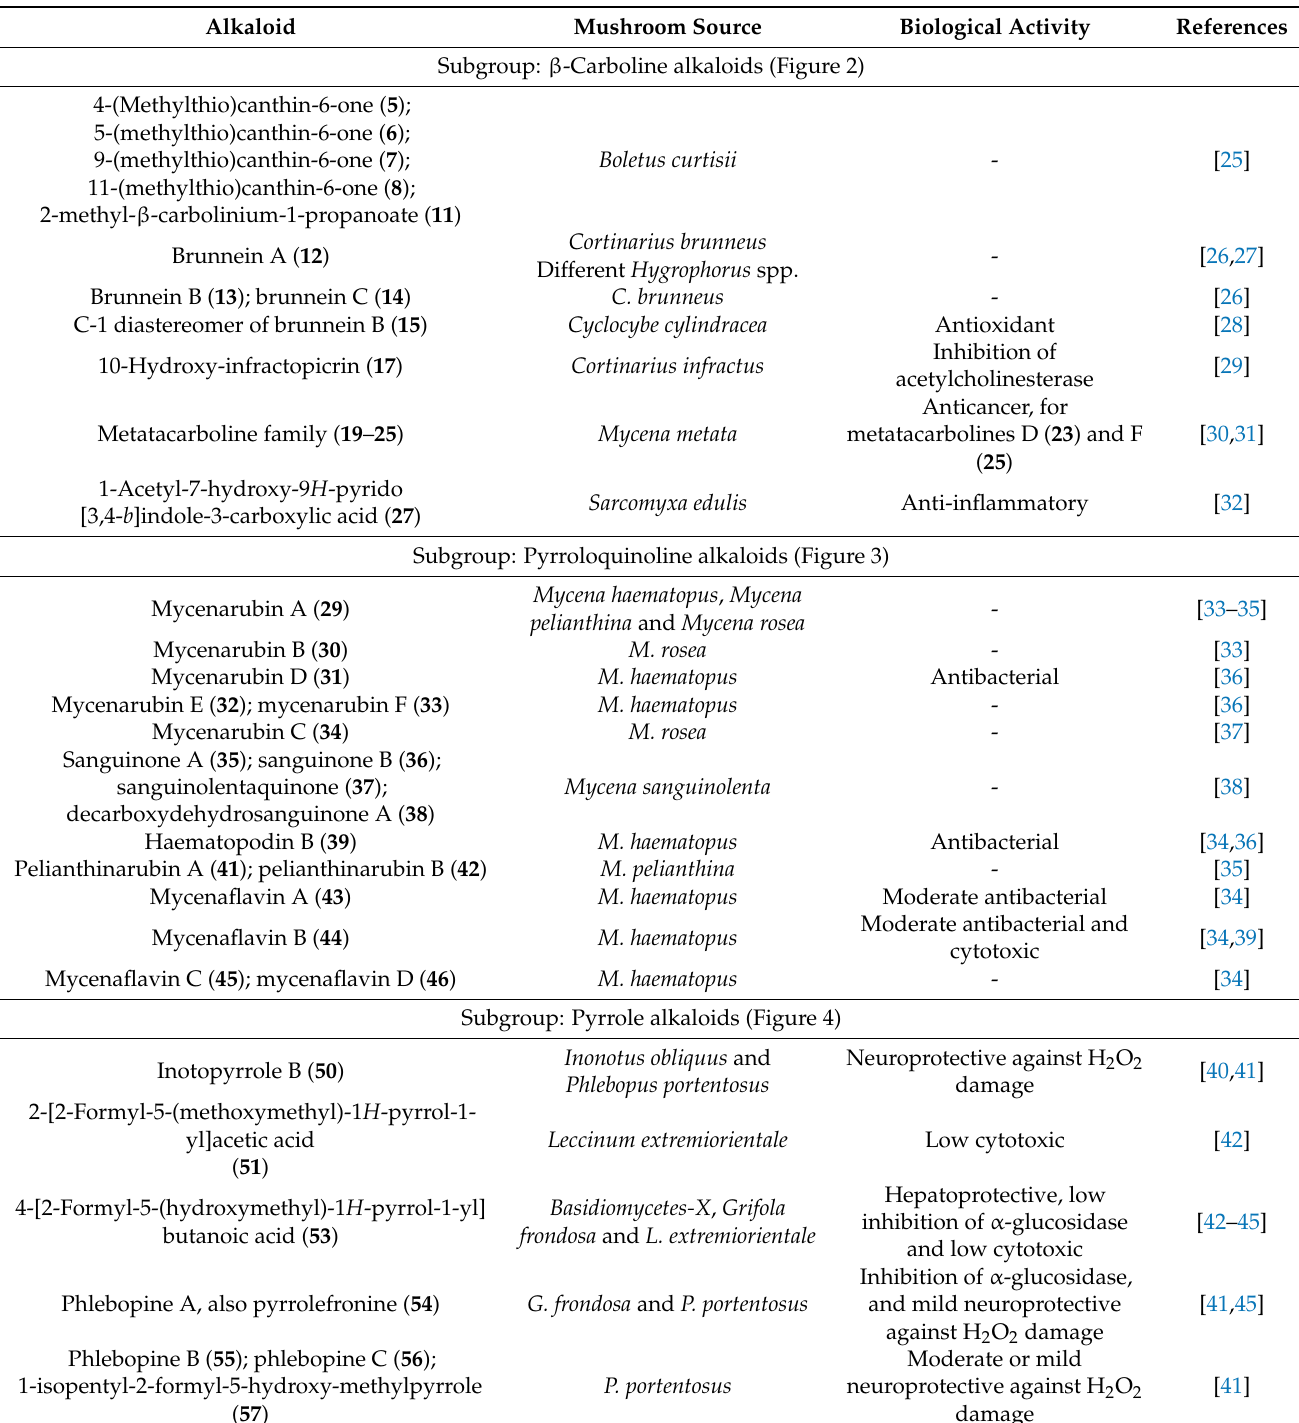
Subgroup: Pyrroloquinoline alkaloids (Figure